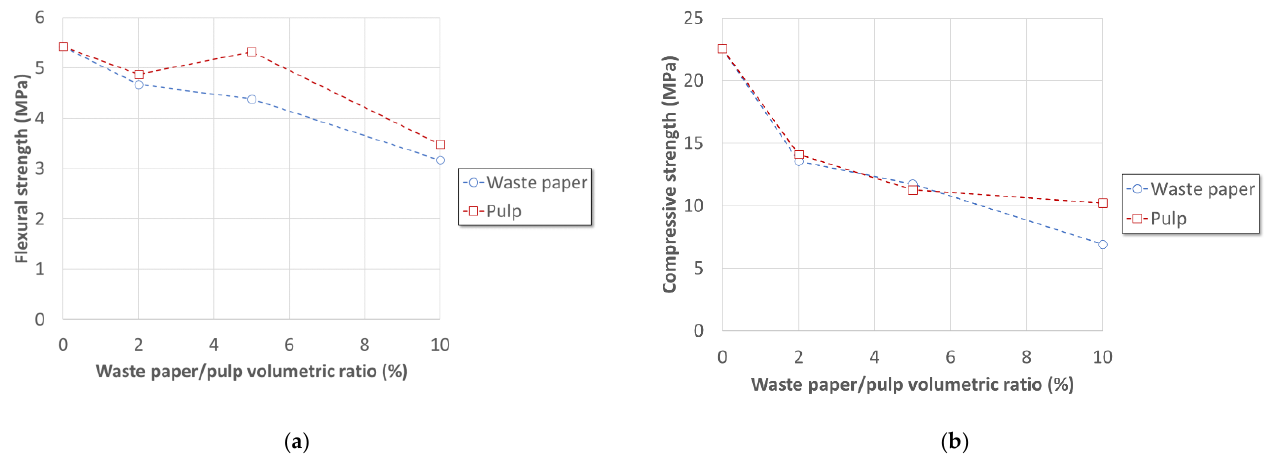
Figure 4. ( a ) Flexural strength and ( b ) compressive strength by varying the waste paper/pulp volumetric ratio.